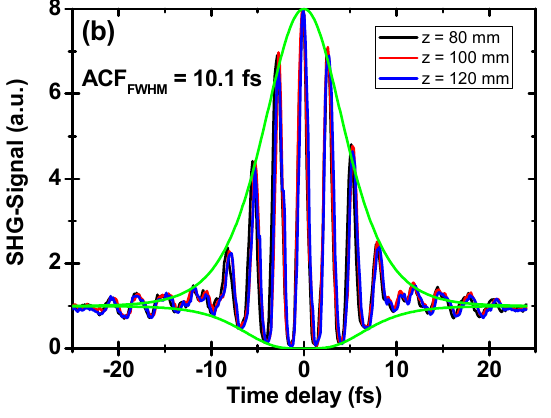
Figure 8. Temporal autocorrelation function of a stadium-shaped light bullet measured at three different axial distances (80 mm, 100 mm and 120 mm). For a sech 2 -pulse shape, one can estimate a nearly constant pulse duration of about 6.6 fs for the propagating light